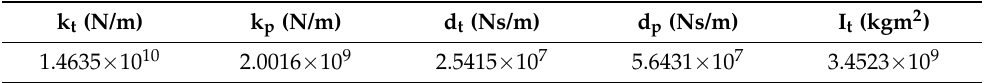
Table 7. Identified parameters of the selected dynamic FOWT